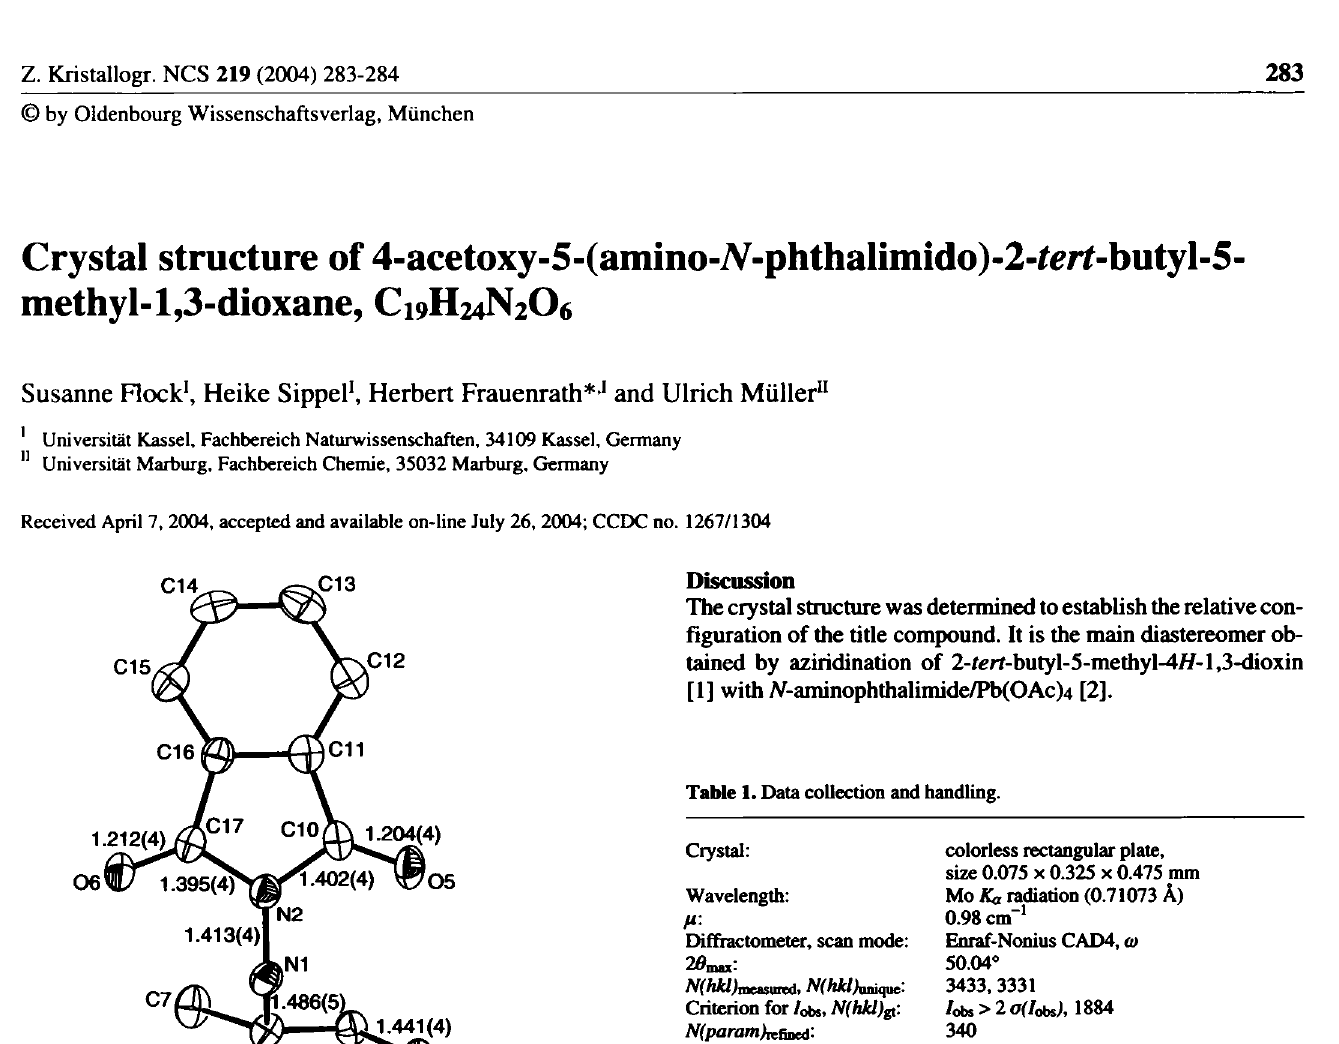
Table 2. Atomic coordinates and displacement parameters (in A 2